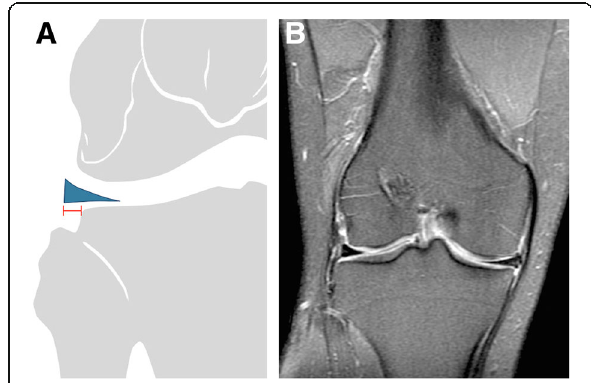
Fig. 2 Meniscal extrusion evaluated in a coronal view MRI, at the level of the medial collateral ligament midportion. a ) Schematic image showing the measurement of the meniscal extrusion. ≥ 3 mm is considered pathological. b ) Coronal T2-weighted MRI showing absence of meniscal